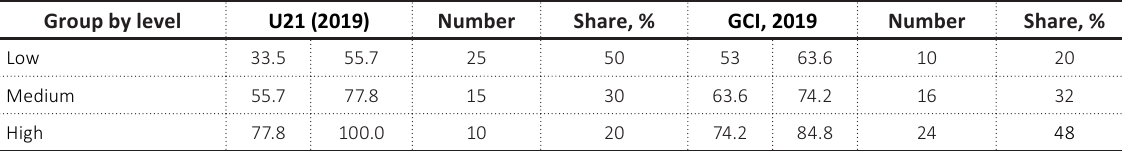
Figure 1. Structural and logical relationships in the system for assessing the impact of education Table 2. Grouping of countries by U21 and GCI Group by level Low